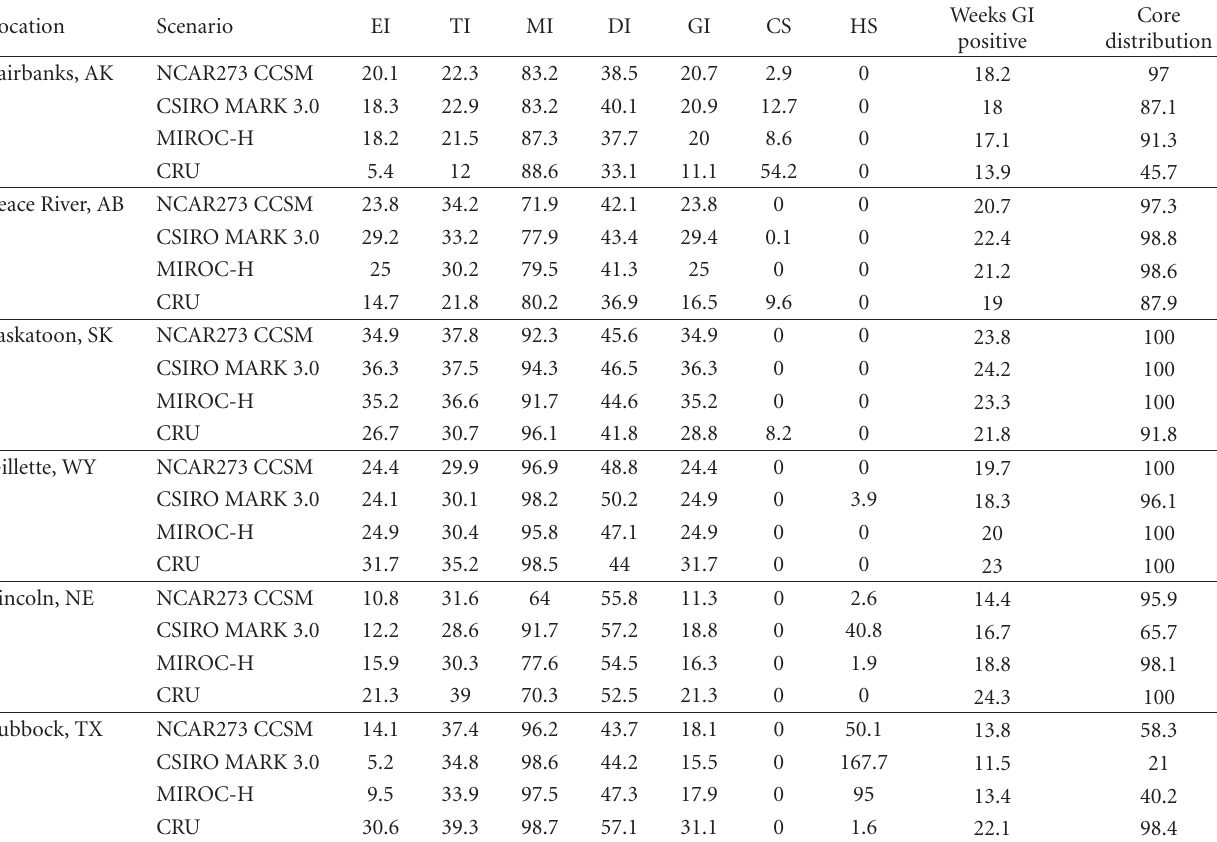
Weeks GI Core positive distribution